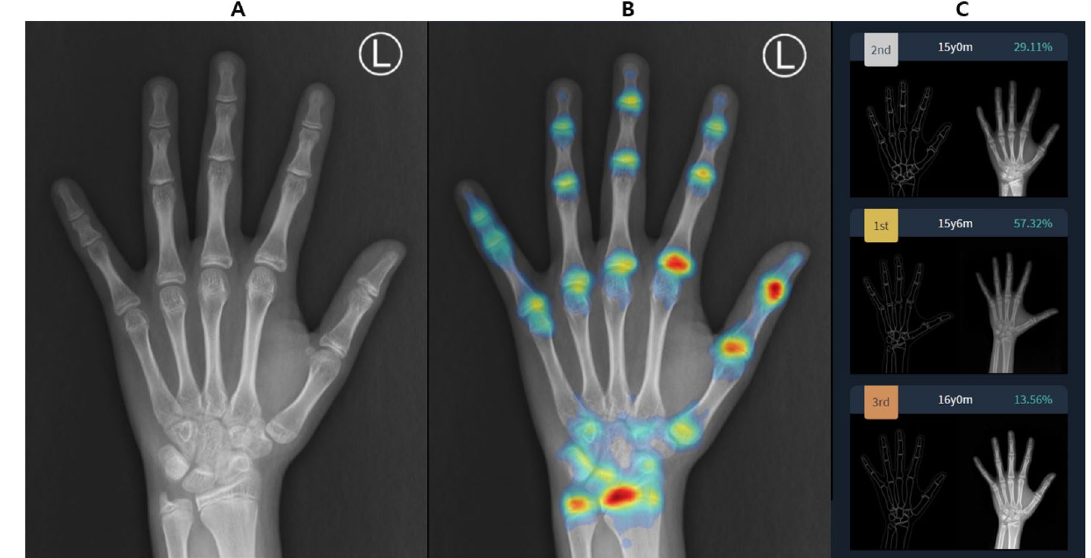
Figure 1. Screenshot of BA assessment by the software. Subject is a male patient with chronological age of 15 years and 3 month. ( A ) The software analyses the received left hand radiograph and ( B ) generates attention map using shape and density of each bone, then ( C ) displays estimated bone ages and each probability according to the attention map. First-rank bone age of this patient is 15 years and 6 months years with probability of 57.32%. The reference radiograph and outline-image depicting a specific shape of each bone are also shown in ( C